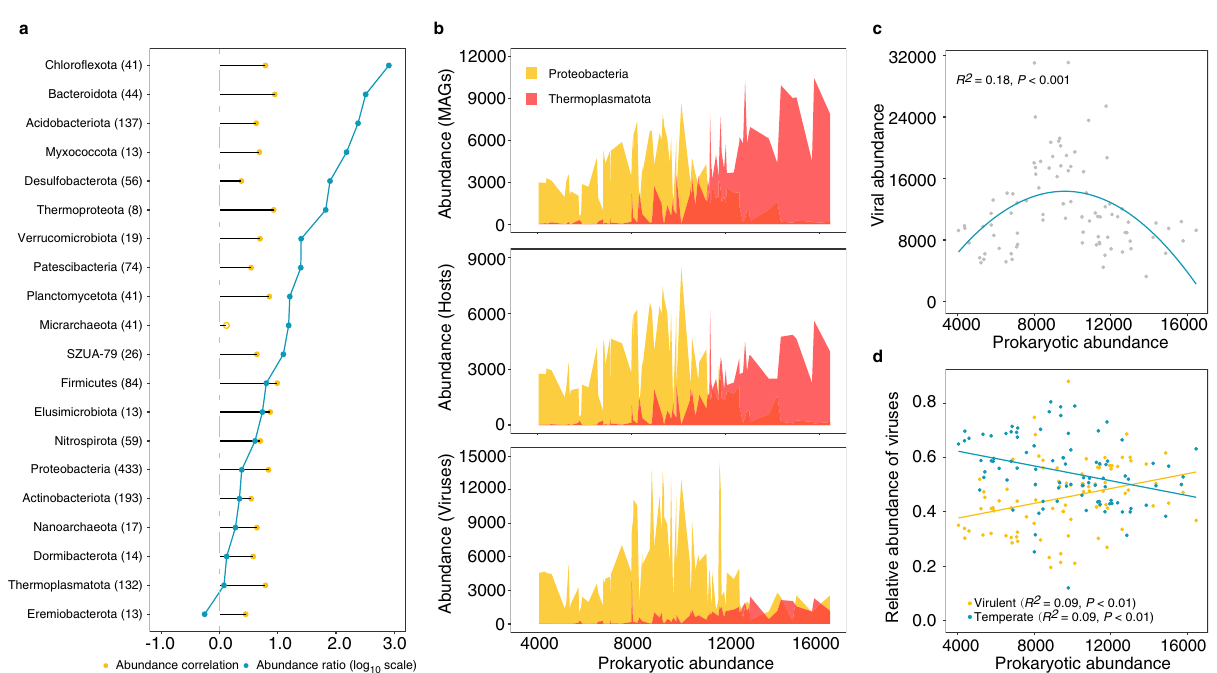
Fig. 4 Virus-host abundance patterns. a The blue and orange dots indicate lineage-speci fi c virus-host abundance ratios (VHRs, log 10 scale) and virus-host abundance correlation coef fi cients, respectively. The solid orange dot represents signi fi cant ( P < 0.05, two-tailed test) Pearson ’ s correlations while the hollow orange dots represent nonsigni fi cant correlations. The Pearson ’ s correlations were calculated across samples in which host phyla and associated viruses were both detected. Numbers in the brackets indicate numbers of predicted host populations. b Top panel: total abundance of Proteobacteria and Thermoplasmatota ; middle panel: total abundance of Proteobacteria hosts and Thermoplasmatota hosts; bottom panel: total abundance of Proteobacteria - associated viruses and Thermoplasmatota -associated viruses. c Relationships between viral abundance and prokaryotic abundance. The blue line indicate best- fi tting polynomial functions. Adjusted R 2 value for this plot is presented. The statistical test used was two-tailed. d Relationships between prokaryotic abundance and summed relative abundances of temperate and virulent viruses. Color-coded best- fi t lines and adjusted R 2 values for each linear regression are presented. The statistical test used was two-tailed. Source data are provided in the Source Data fi